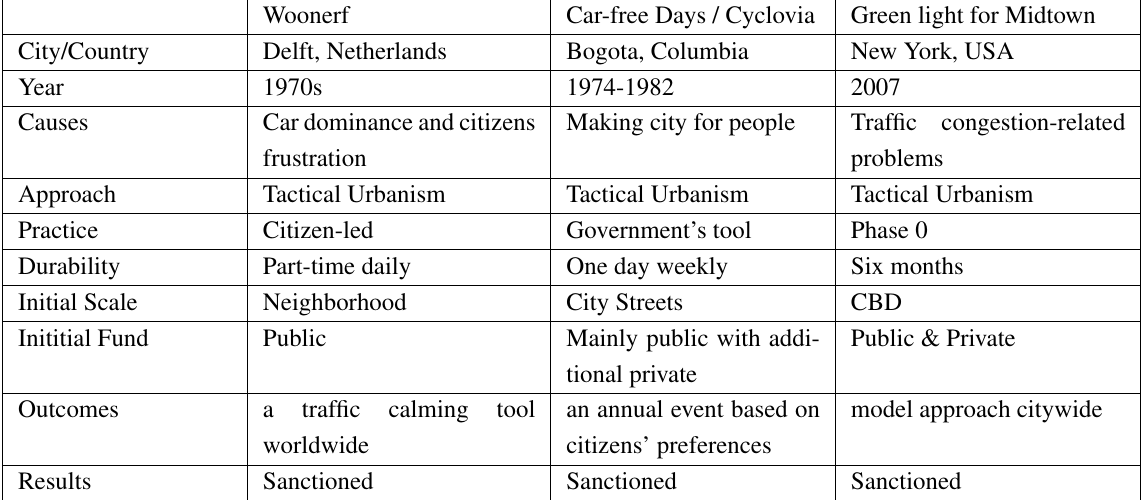
Table 2. Represents a comparative analysis of three practices of tactical urbanism in pedestrianization (Researcher, 2018) Woonerf Car-free Days / Cyclovia Green light for Midtown